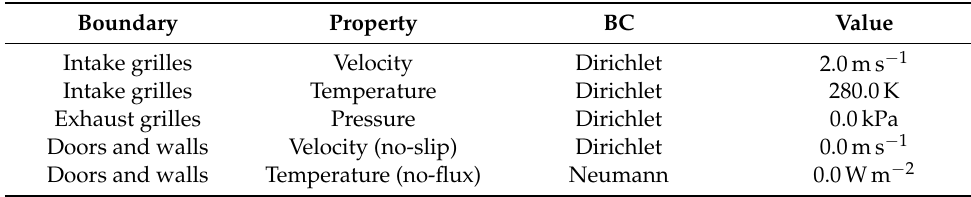
Table 3. Boundary conditions imposed on the numerical simulation